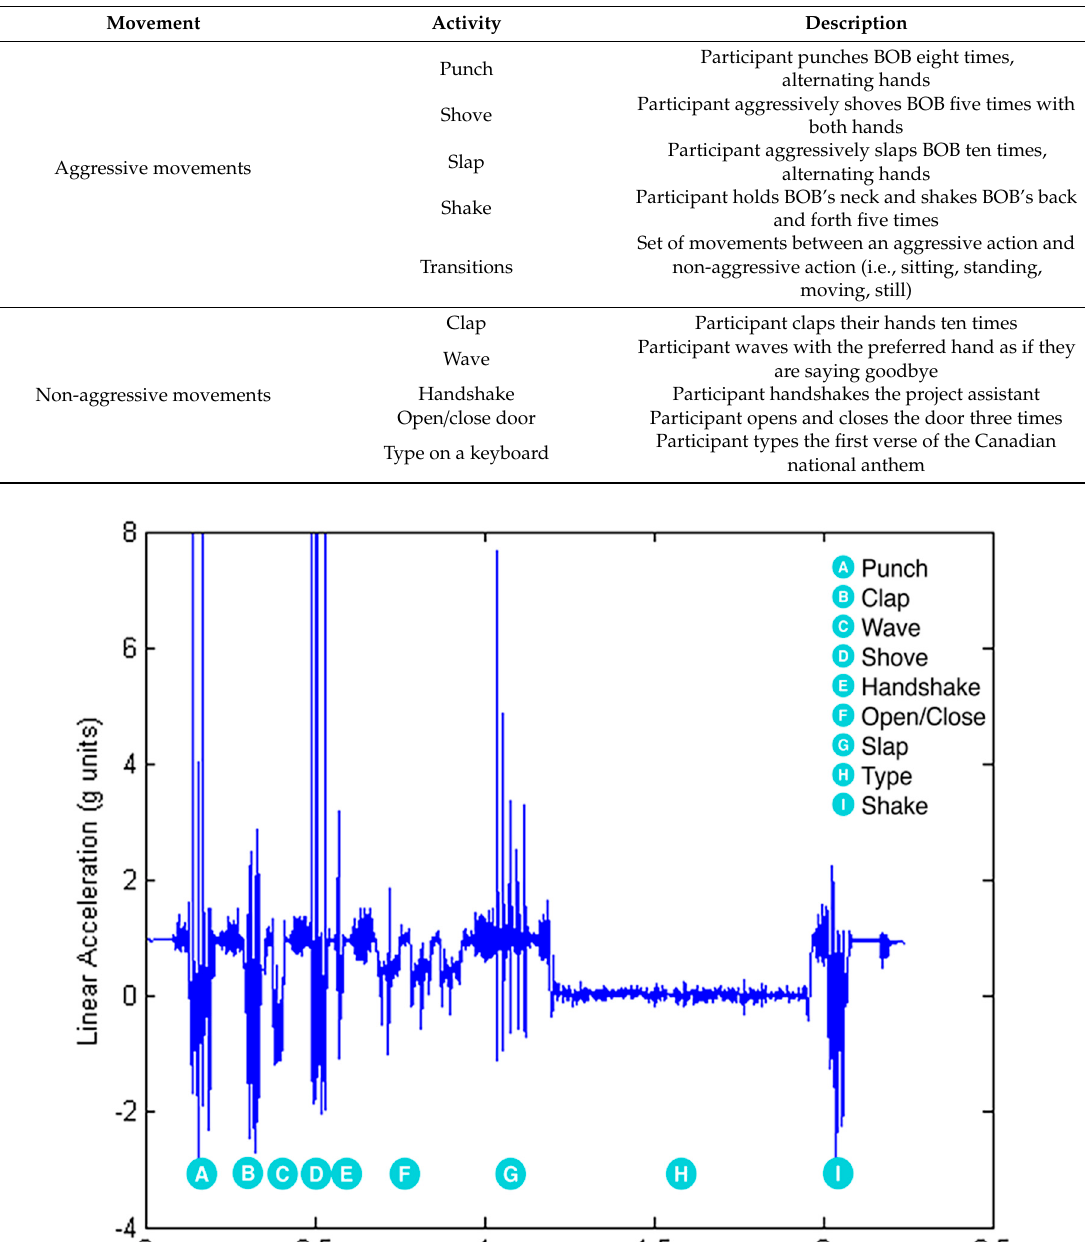
Figure 3. Tri-axial linear acceleration of participant 1.